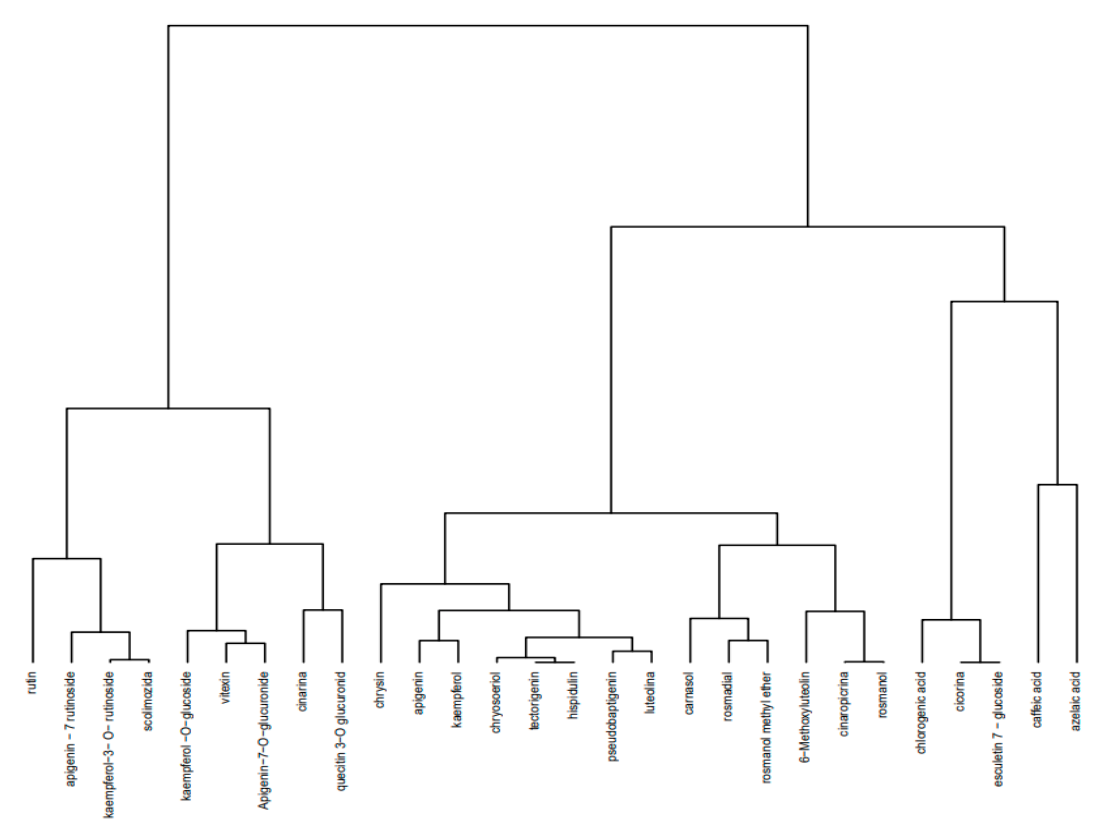
Figure 2. Dendrogram for CE compounds representative of the profile of polyphenolic derivatives obtained by the hierarchical grouping method Ward-HCA (Hierarchical Cluster Analysis). Table 3. Chemical compounds identified in RE by UHPLC–HRMS/MS.